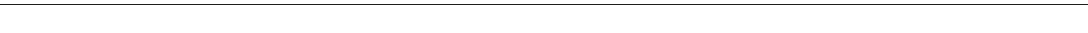
Fig. 5 ITGA4 + de fi nes molecularly distinct subsets of articular cartilage that are enriched for osteochondral proteins. a BMPR1B (red) identi fi es many cells of the super fi cial layer of adult human articular cartilage. b ITGA4 (green) labels rare cells in the most super fi cial region of adult human articular cartilage. c DAPI (blue) labels nuclei. d Merge channels. Arrow labels a BMPR1B + ITGA4 + cell, arrowhead labels a BMPR1B + ITGA4 − cell and asterisk labels a BMPR1B − ITGA4 − cell. Dotted line indicates articular surface. e Flow cytometry of adult pig chondrocytes identi fi ed four populations of cells based on expression of BMPR1B and ITGA4. f – i Western Blot analysis and quanti fi cation of protein expression in adult pig chondrocytes sorted on expression of BMPR1B (B1B) and ITGA4 (A4). SOX9 (f), GLI1 ( g ), pSTAT3 ( h ), and RUNX2 ( i ) are all signi fi cantly enriched in BMPR1B + ITGA4 + cells compared to other sorted populations as calculated by one-way ANOVA followed by Tukey ’ s multiple comparison test. j The four populations of sorted pig chondrocytes were sequenced and differential expression analysis was performed in pairwise fashion. 38 genes are uniquely enriched in BMPR1B + ITGA4 + cells compared to all other population. k GO analysis of these 38 genes. N = 3; scale bars = 50 μ